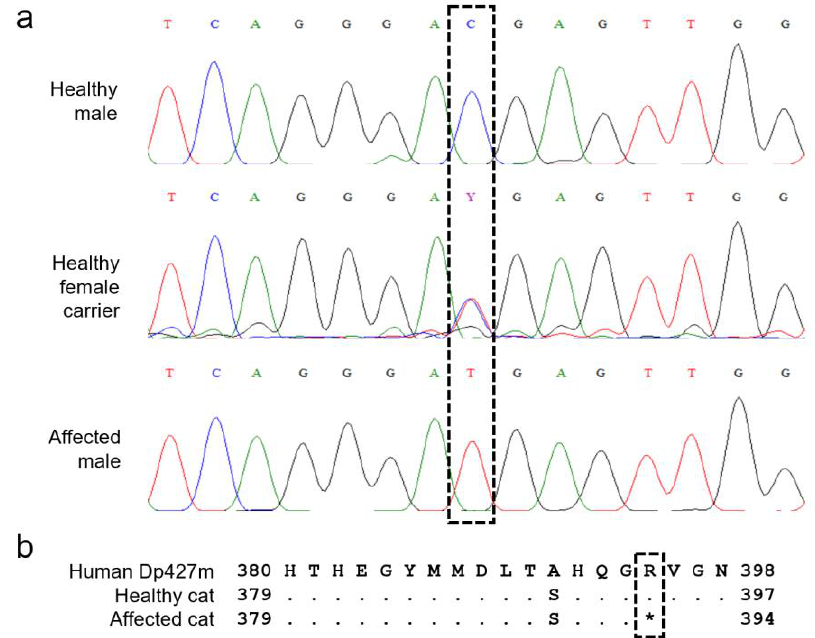
Figure 3. Disease-associated variant. ( a ) Chromatogram alignment of a healthy male, a healthy female carrier, and an affected male. ( b ) Protein alignment of the sequence around the variant. A * indicates the end of the protein.